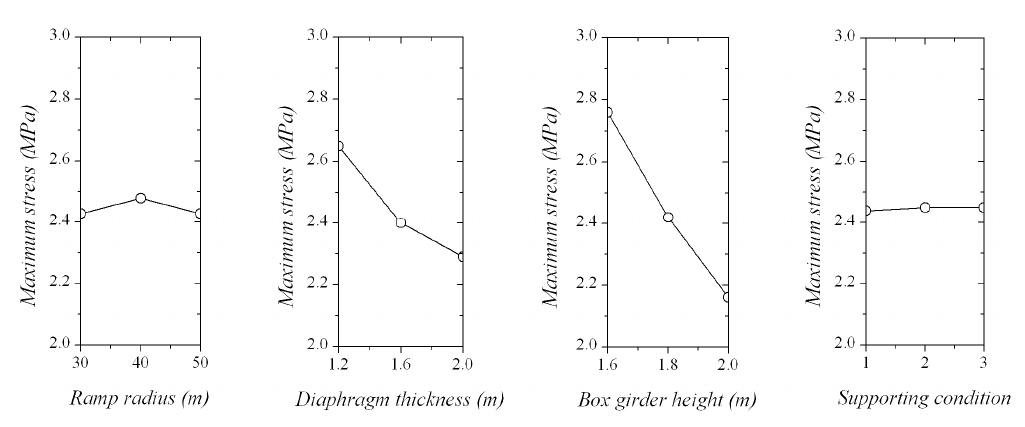
Figure 7. Influence of varying parameters on maximum stress.